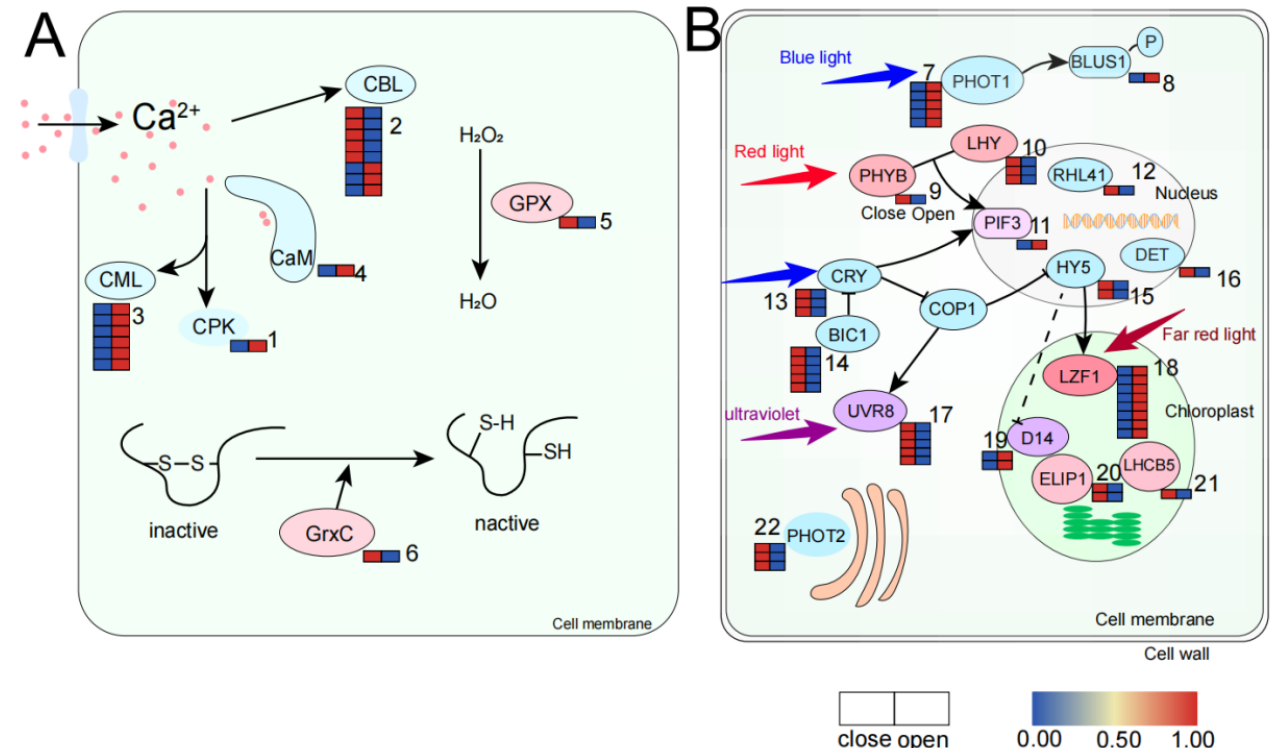
Figure 4. Expression patterns of genes in signal transduction pathways during open and closed periods. ( A ) Gene expression of Ca 2+ signaling and ROS signaling pathway (the corresponding genes are listed in Table 1 according to the labeled number “1” to “6” in each map). ( B ) Gene expression in the photosignaling pathway (the corresponding genes are listed in Table 2 according to the labeled number “7” to “22” in each map). Red and blue colors indicate upregulated and downregulated transcripts, respectively. Proteins of the same color represent the fact that they are in the same signaling pathway. The blue color in ( A ) represents the Ca 2+ signal transmission pathway, and the light pink color represents the ROS signal transmission pathway. In ( B ), blue represents the blue-light signal transmission pathway, pink represents the red-light signal transmission pathway, dark pink represents the far-red light signal transmission pathway, and purple represents the ultraviolet signal transmission pathway. The lilac in PIF3 represents the fact that the PIF3 gene is affected by both red and blue light.